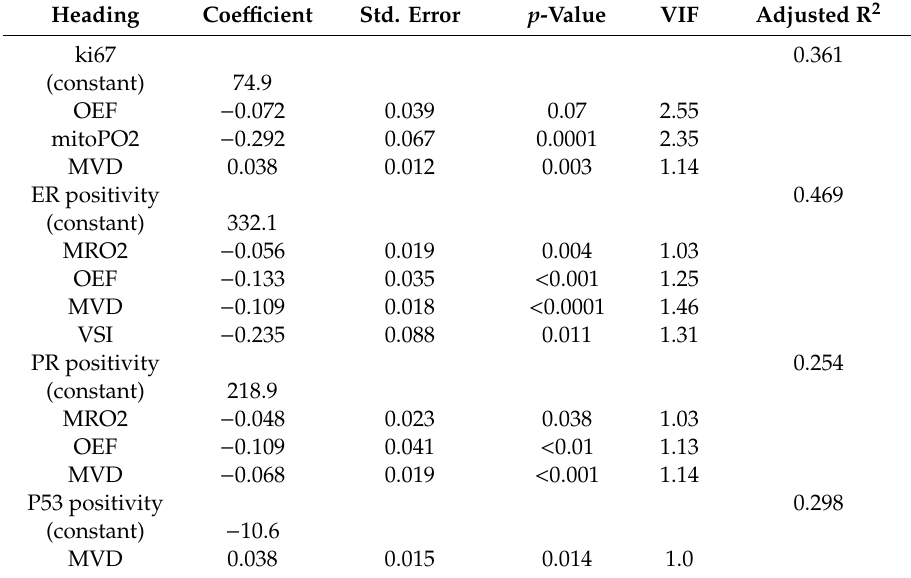
Table 4. Multiple regression analysis for prediction of ki67, ER, PR, and p53 positivity by qBOLD and VAM-derived features.